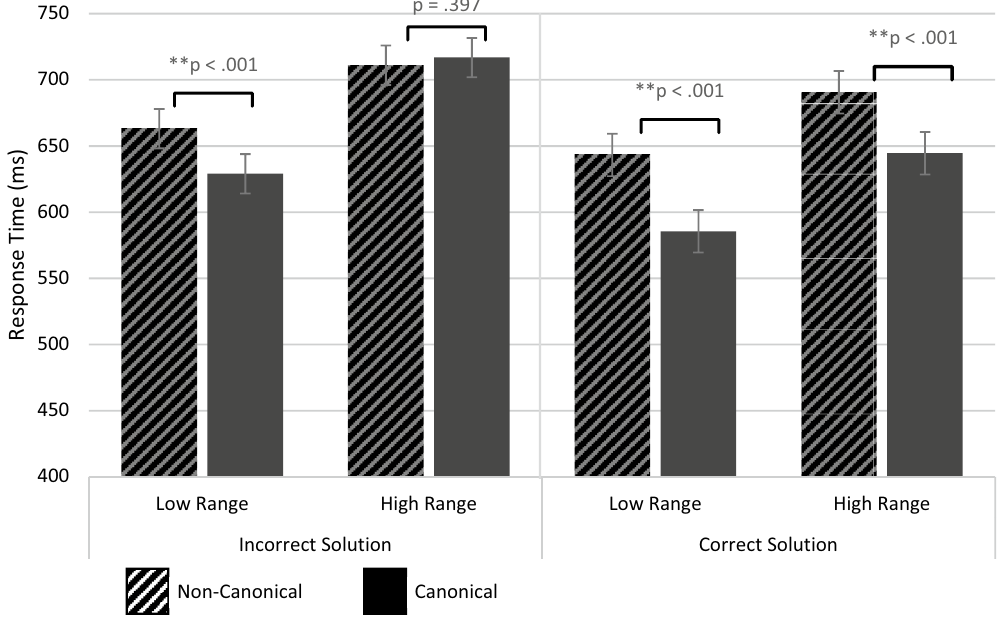
Figure 1. Canonicity effects on reaction time for the low and high numerical ranges and for incorrect and correct sum solution trials (three-way Canonicity × Numerical Range × Solution